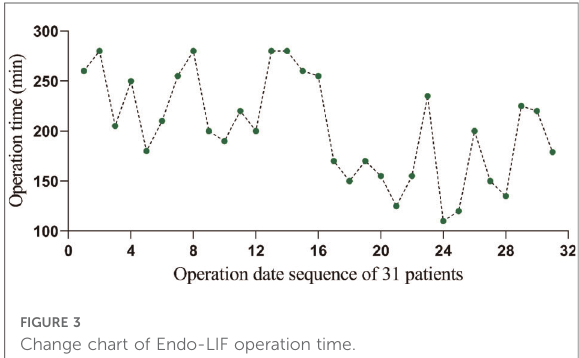
FIGURE 3 Change chart of Endo-LIF operation